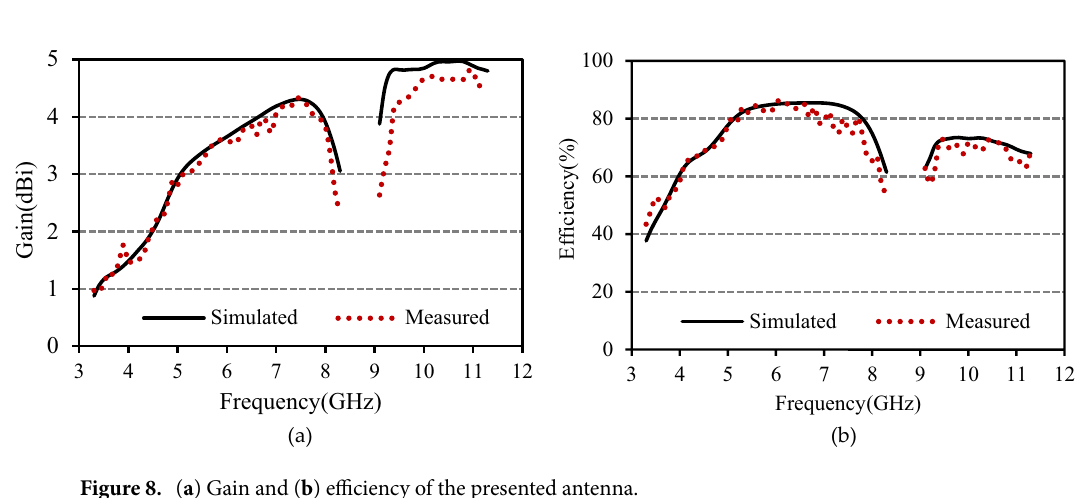
Figure 8. ( a ) Gain and ( b ) efficiency of the presented